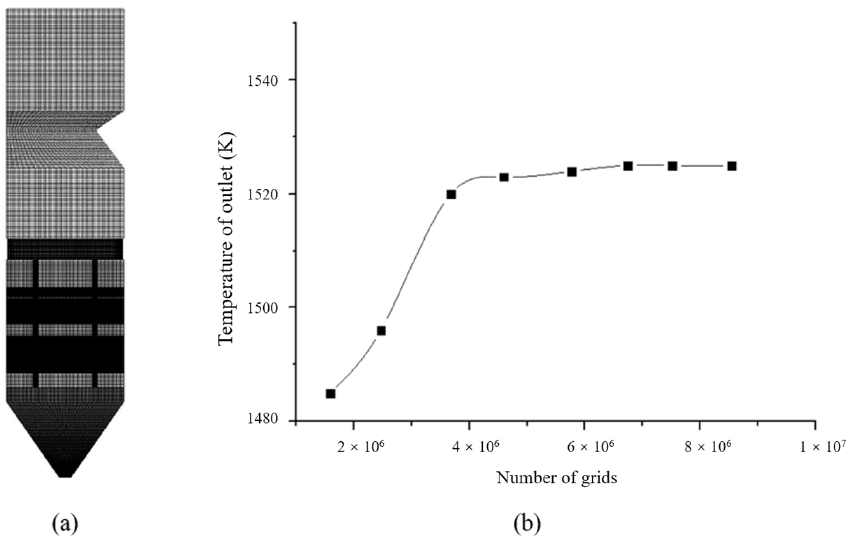
Figure 2. Boiler calculation zone grid. ( a ) Grid model. ( b ) Grid independence analysis.